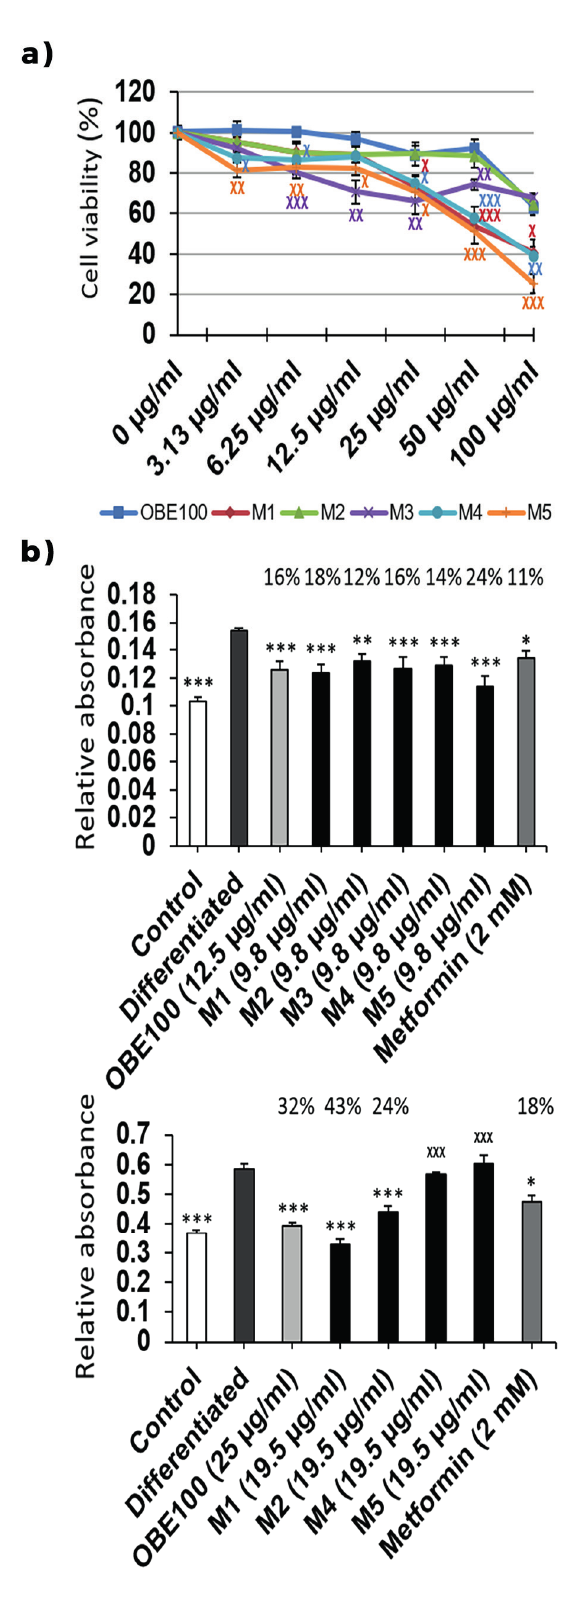
Figure 5. Effect of triterpenoid mixtures on cell viability and lipid accumulation in 3T3-L1